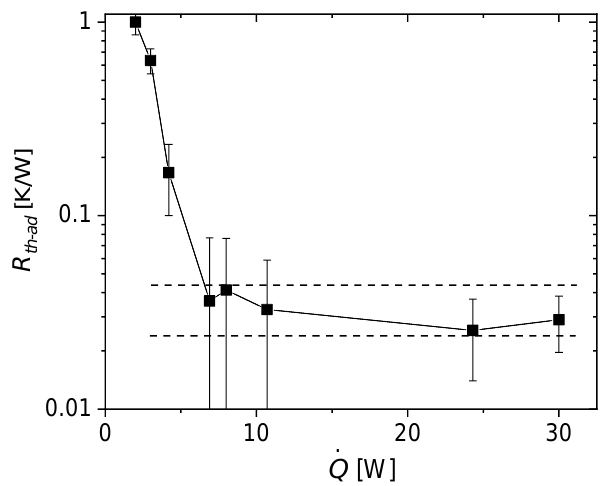
Figure 16. R th − HC versus heater temperature. Figure 16. 𝑅 𝑡ℎ−𝐻𝐶 versus heater temperature